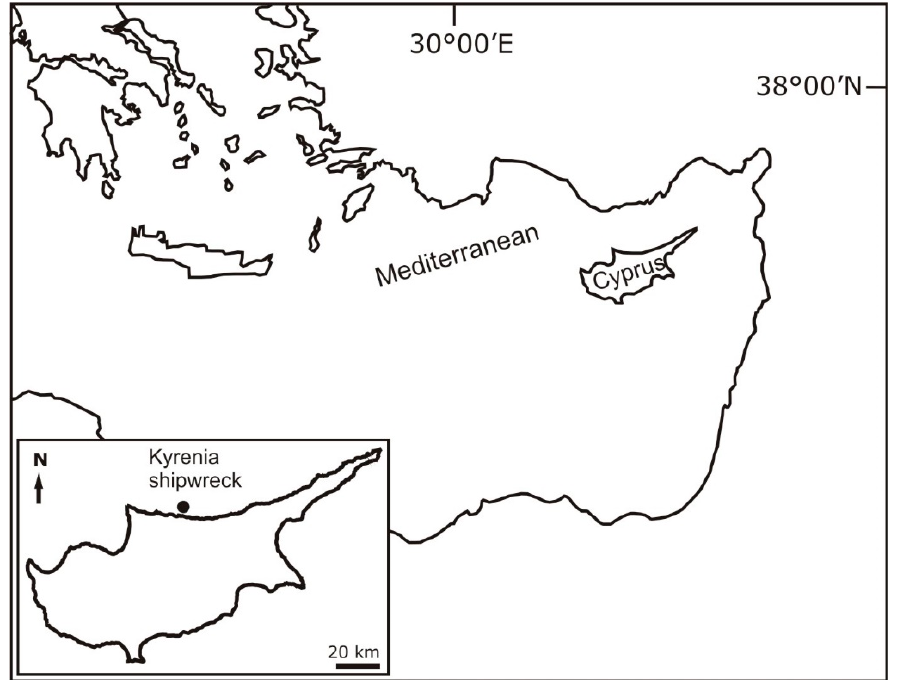
Figure 1. Map and location of the Kyrenia shipwreck.